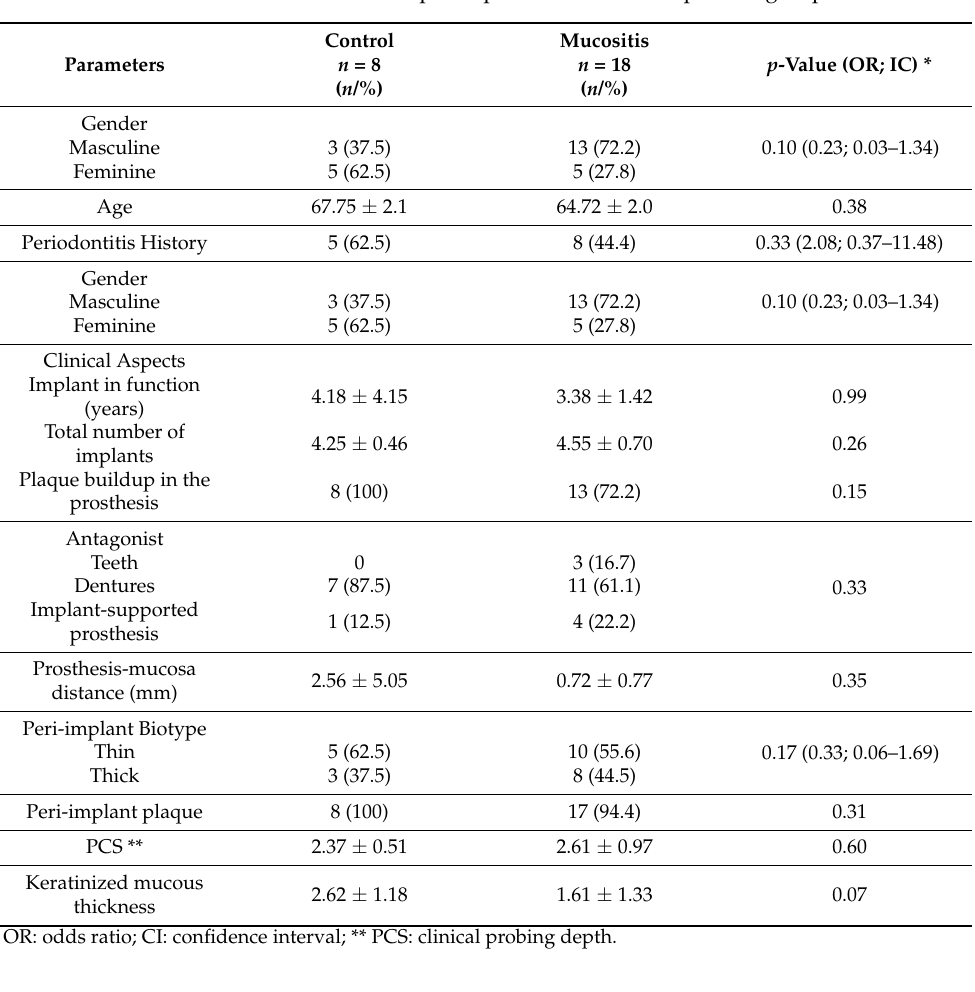
Table 2. General characteristics of research participants and clinical aspects in groups 3 and 4.